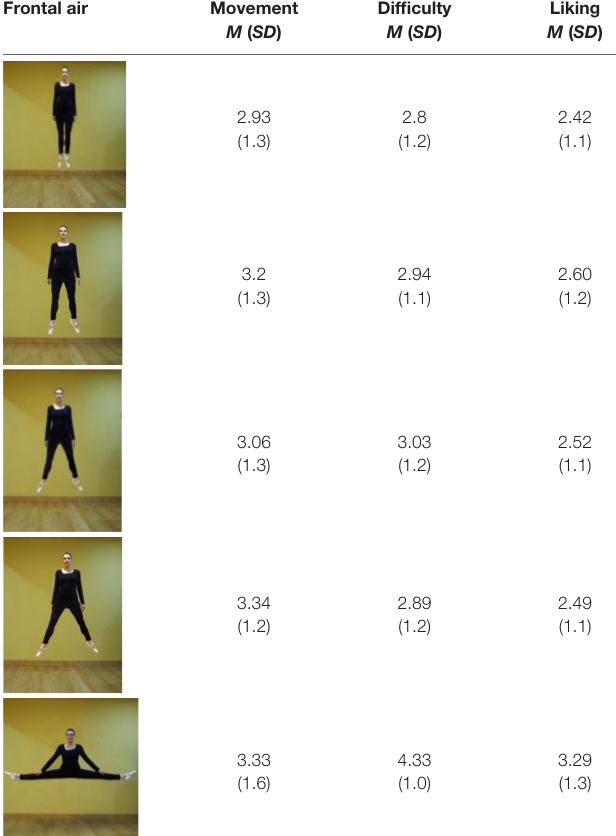
TABLE 1 | Frontal in-air poses: mean ratings (and SD) for movement, difficulty, and